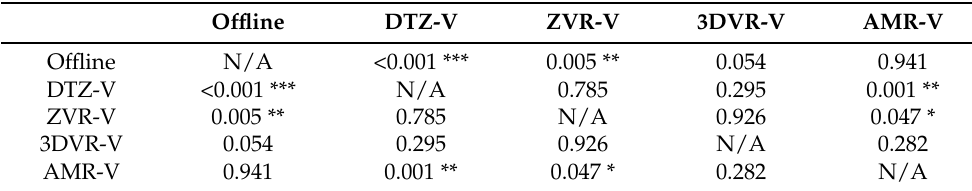
Table A2. STAI post hoc—Tukey HSD (Statistically significance levels: * p < 0.05; ** p < 0.01;